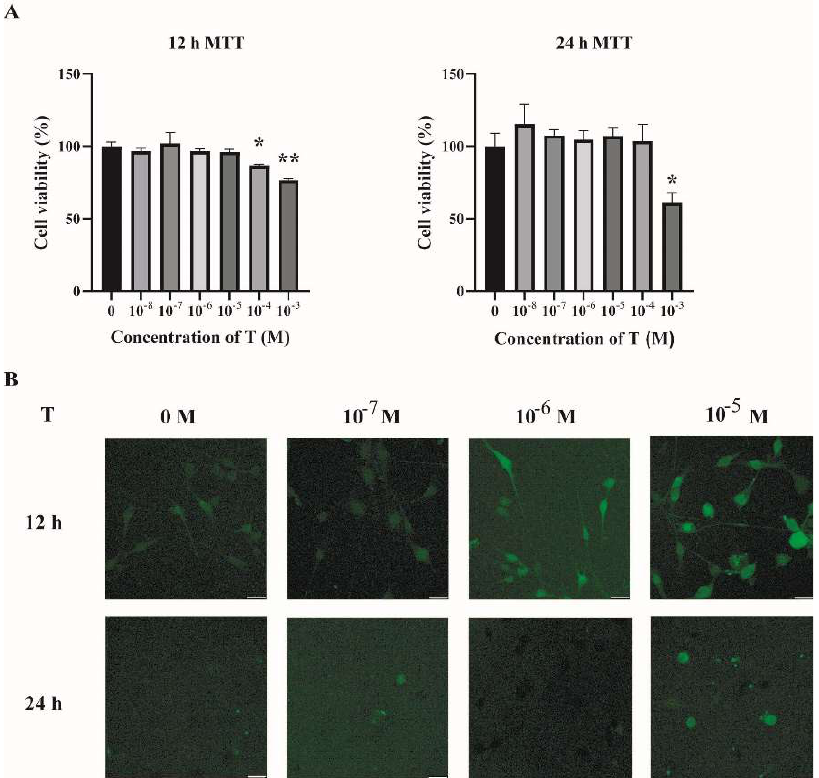
Figure 3. Increased ROS levels in T-treated C2C12 cells. ( A ) Fully differentiated C2C12 cells were treated with T (0, 10 −8 , 10 −7 , 10 −6 , 10 −5 , 10 −4 , and 10 −3 M) for 12 h and 24 h. Cell viability was then measured by MTT assay. The data are means ± SEM of three independent experiments. Asterisks indicate significant differences between the vehicle-treated group and the different T treatment concentrations. *, p < 0.05, **, p < 0.01. ( B ) Representative photomicrographs of intracellular ROS detection in C2C12 cells after exposure to T at different concentrations for 12 h and 24 h. Intracellular ROS levels were quantified by DCFH-DA staining. Scale bar = 25 μm. T= testosterone.